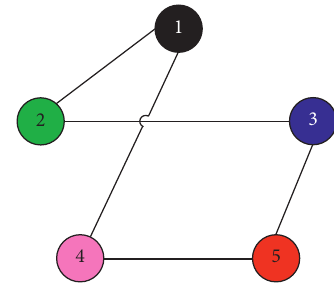
Figure 1: Communication